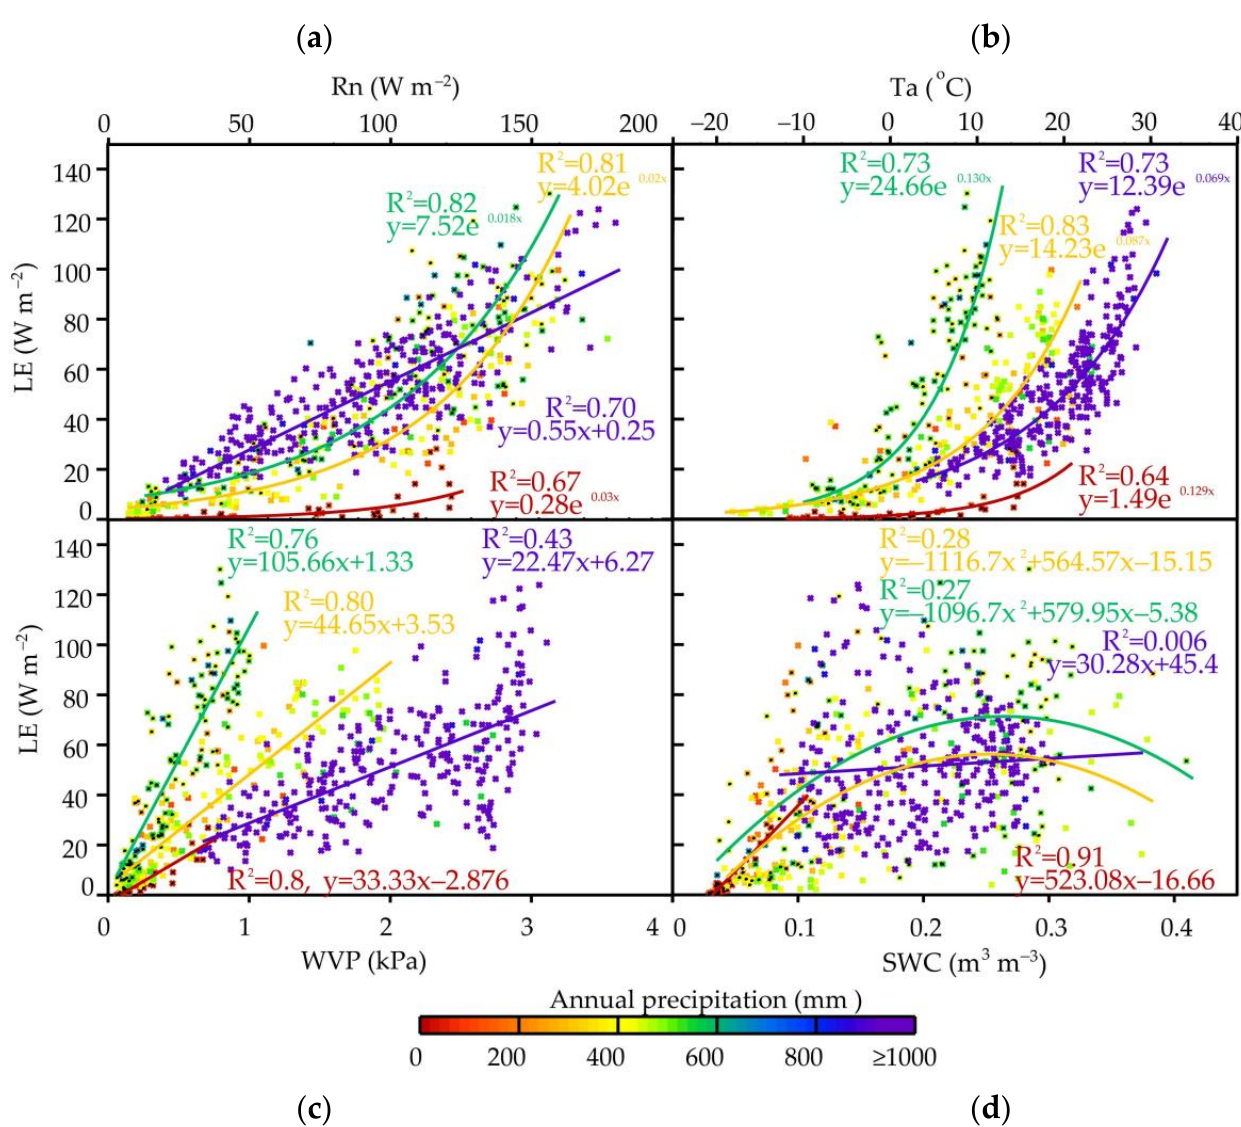
Figure 6. Correlation between ET and Rn ( a ), Ta ( b ), WVP ( c ), and SWC ( d ). The black dots are the data of the alpine zones. The red fitting line indicates the data of SQH station. The green fitting line indicates the alpine zones, except the SQH station. The yellow fitting line indicates the area where the altitude is less than 3 km, with annual precipitation levels lower than 800 mm (as NM, SACOL and CBS stations in this study). The purple fitting line indicates the area with an altitude of lower than 3 km and annual precipitation exceeding 800 mm (as DHS, QYZ, and XSBN stations in this study). Figures 7 and 8 are similar to Figure